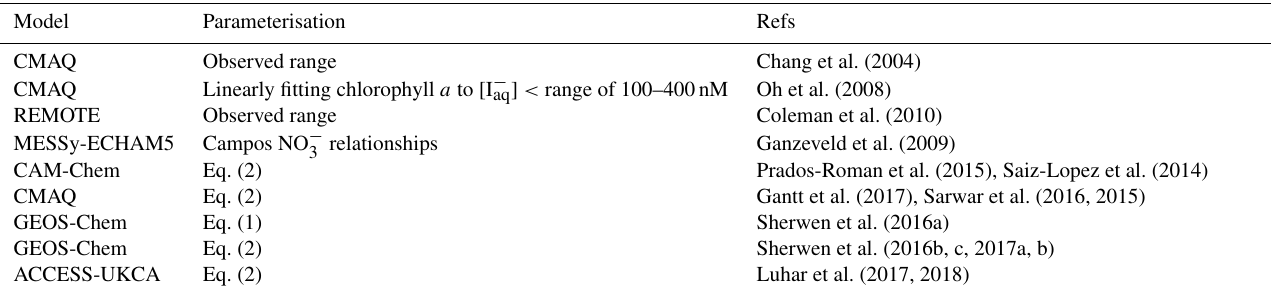
Table A1. Summary of sea-surface iodide parameterisations in global and regional atmospheric